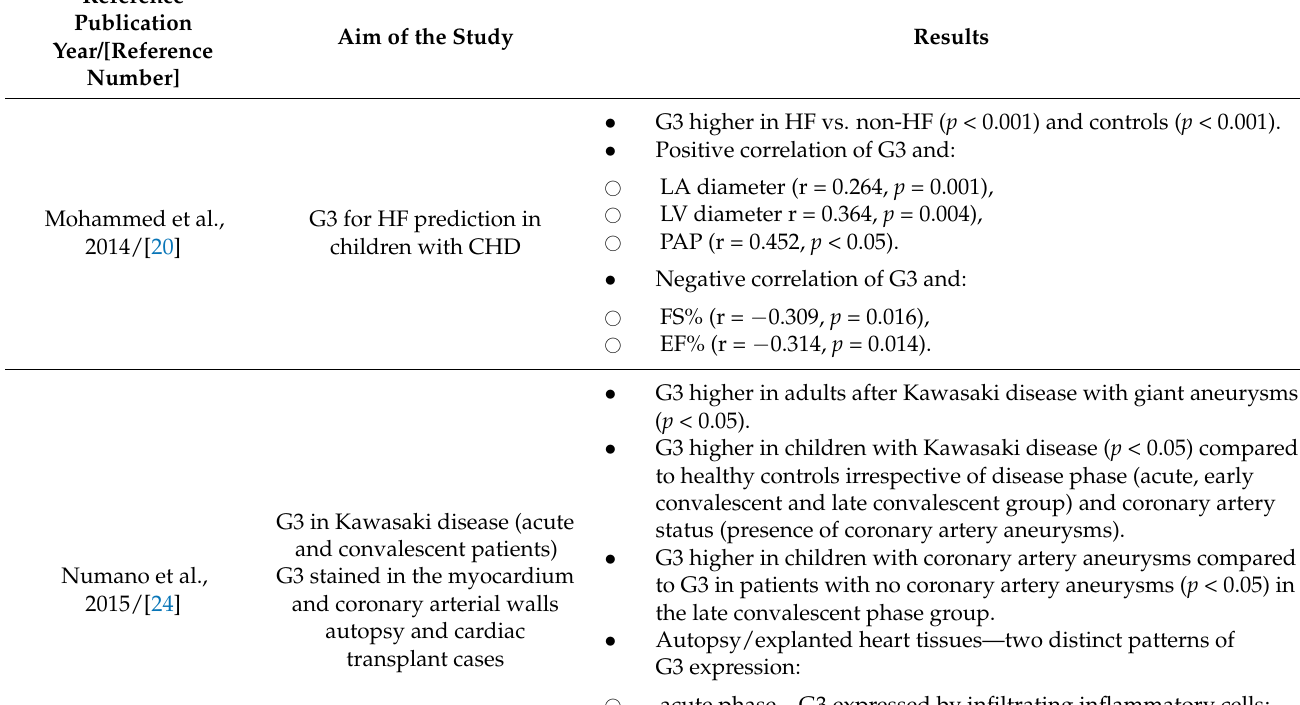
Table 1. Galectin-3 in pediatric populations with cardiovascular